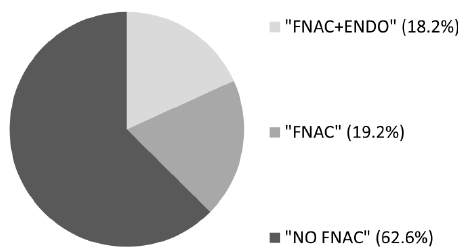
Figure 2. Distribution of the 1080 patients operated on for thyroid nodules between 2012 and 2015 according to the 3 care pathway types. FNAC: Fine-Needle Aspiration Cytology; ENDO: endocrinology consultation.